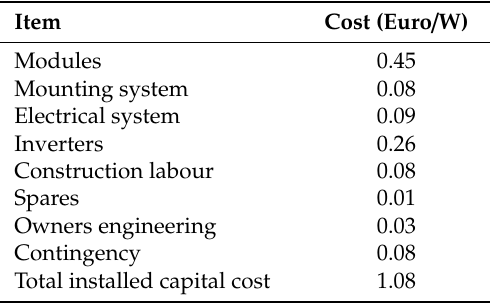
Table 5. PV total installed capital cost.